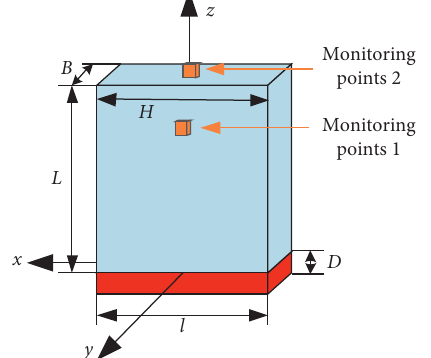
Figure 5: Schematic diagram of the experimental